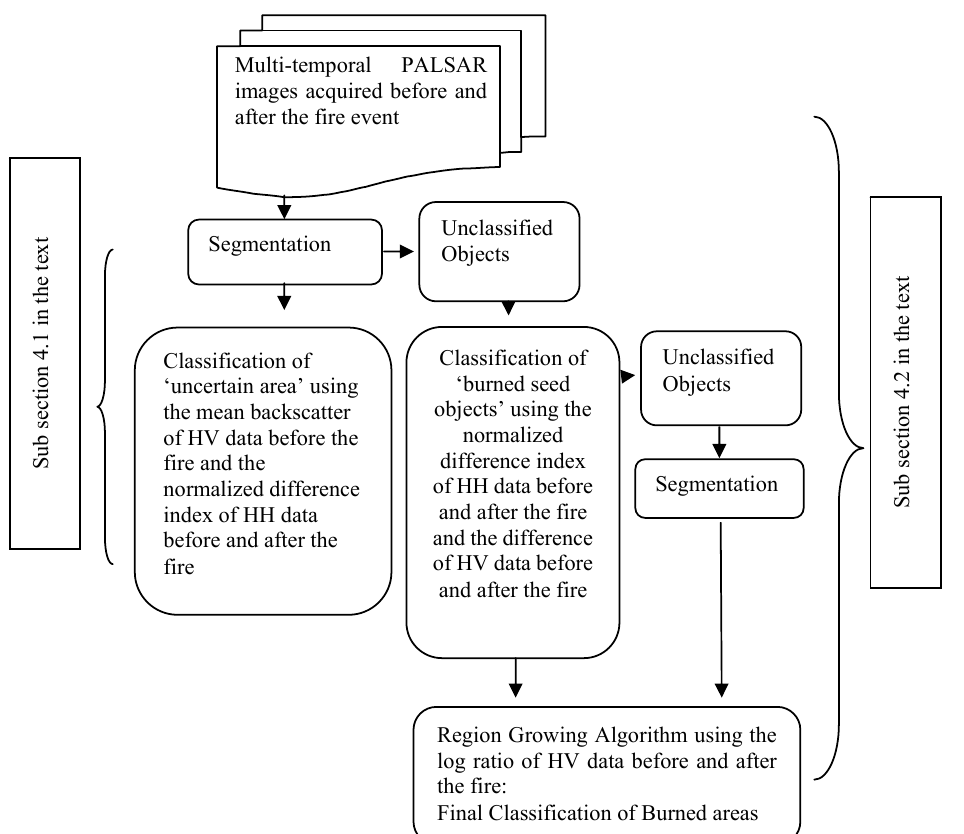
Figure 5. Flowchart of the basic steps followed for the development of the object-based classification scheme for burned area mapping using Advanced Land Observing Satellite (ALOS) Phased Array type L-band Synthetic Aperture Radar (PALSAR) images (H: Horizontal and V: Vertical